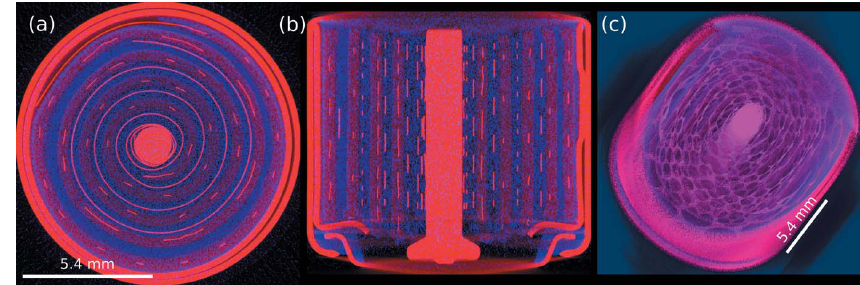
Figure 7 Combined neutron and X-ray tomography of a primary cell with LiMnO 2 chemistry shown as a composite image. The blue channel depicts the linear neutron attenuation coefficient, the red channel the X-ray counterpart. Slices through the reconstructed volume along different directions are given in ( a ) and ( b ); a 3D rendering in ( c ). Cell diameter is 11.6 mm, voxel size 14.2 m m (cid:5) 14.2 m m (cid:5) 14.2 m m.